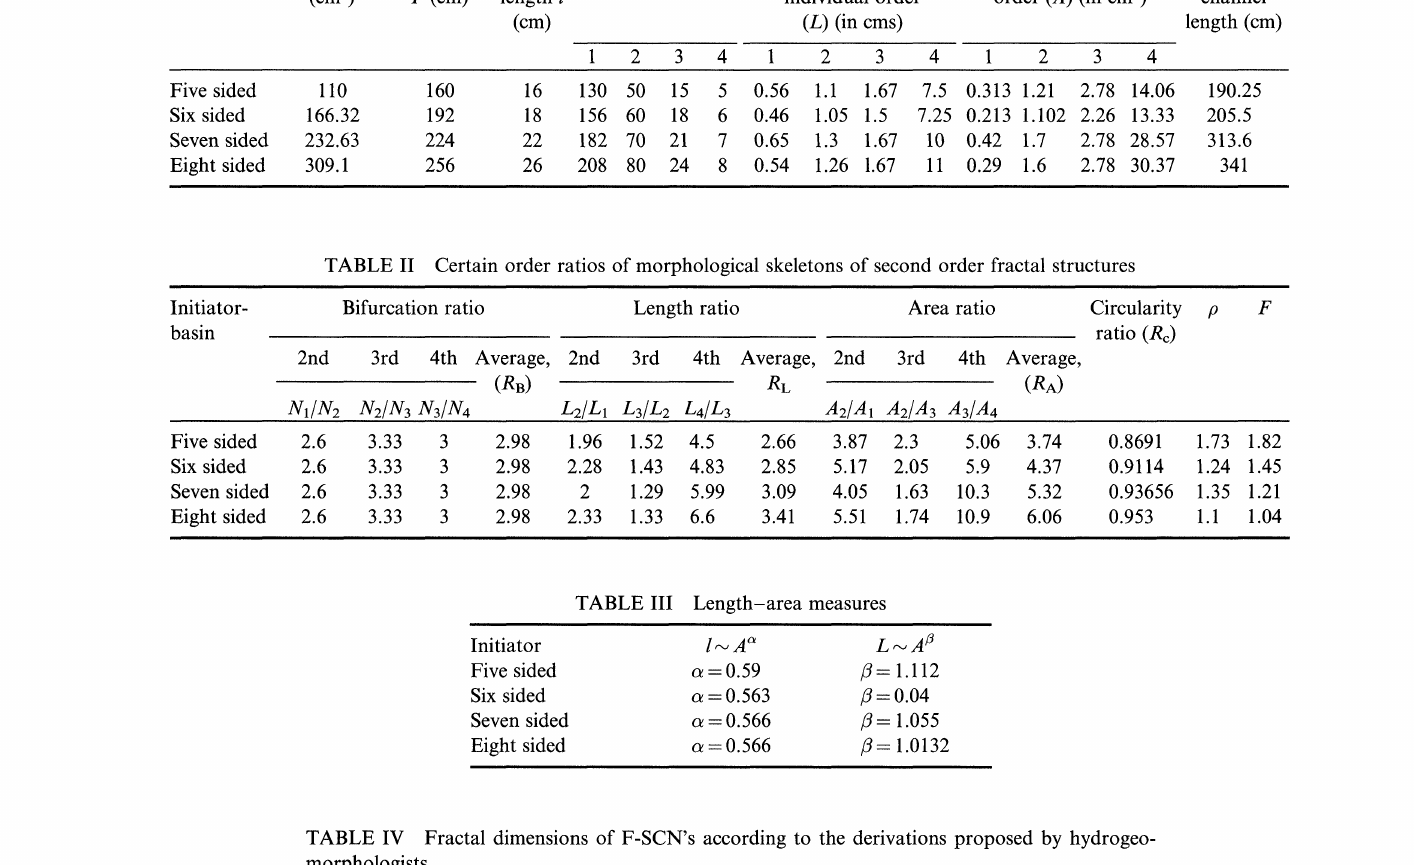
TABLE V Fractal dimensions of fractal structure, morphological skeleton, and main skeletal